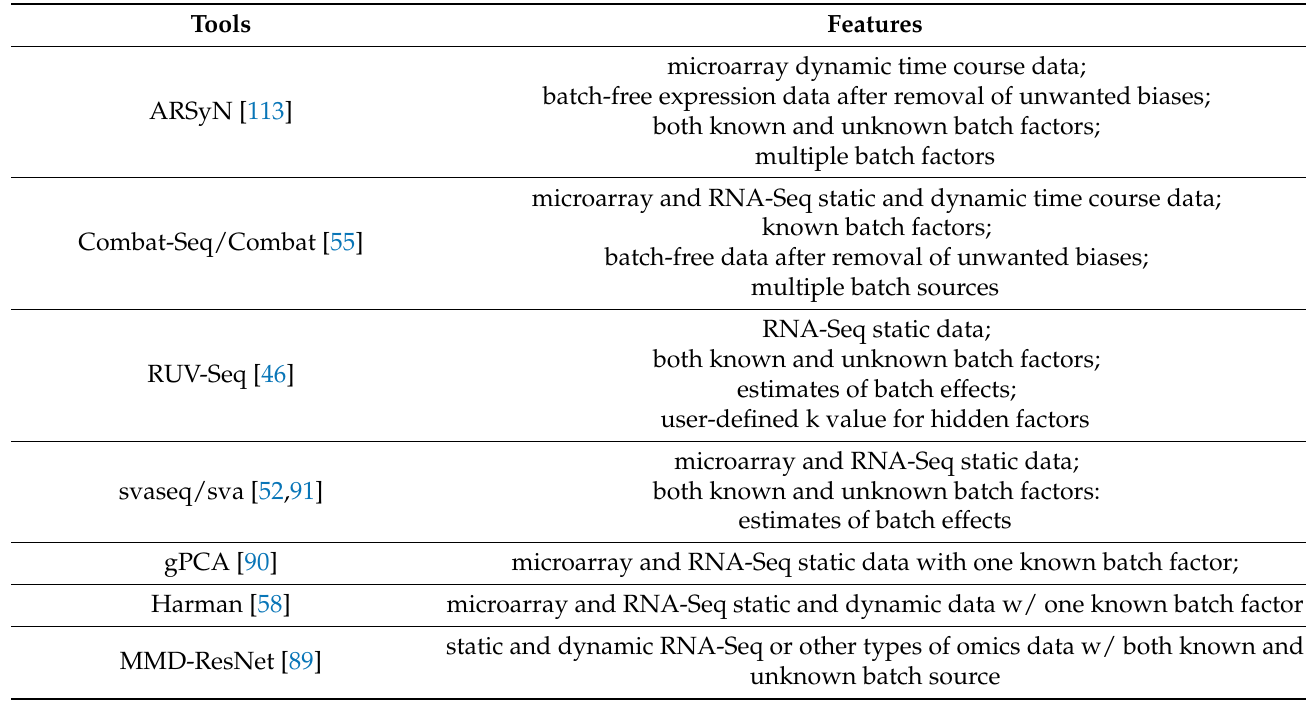
Table 3. State-of-art batch detection